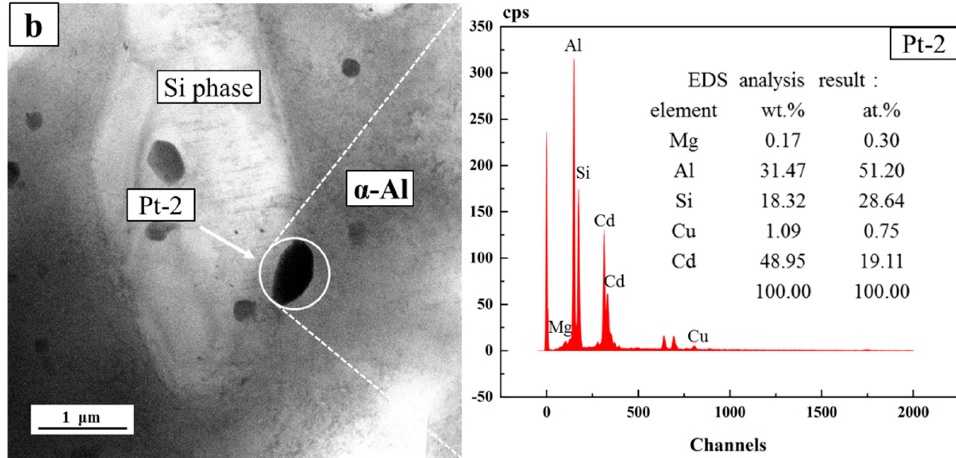
Figure 11. EDS analysis of precipitates near Si phase in Cd-containing alloys after solute treatment: ( a ) two-stage-Cd-containing alloys and ( b ) three-stage-Cd-containing alloys. The impurity diffusion coefficient in solids is usually described by the Arrhenius equation: (cid:16) (cid:17) (cid:2901) − Q D = D 0 exp (cm 2 /s), where D 0 denotes as the pre-exponential factor, Q the activation energy, T the absolute temperature, and R the gas constant [40–42]. D (Cu/Al) = 0.06~20 cm 2 /s, Q (Cu/Al) = 133.9~136.1 kJ/mole, D (Cd/Al) = 1.04 cm 2 /s, Q (Cu/Al) = 124.3 kJ/mole